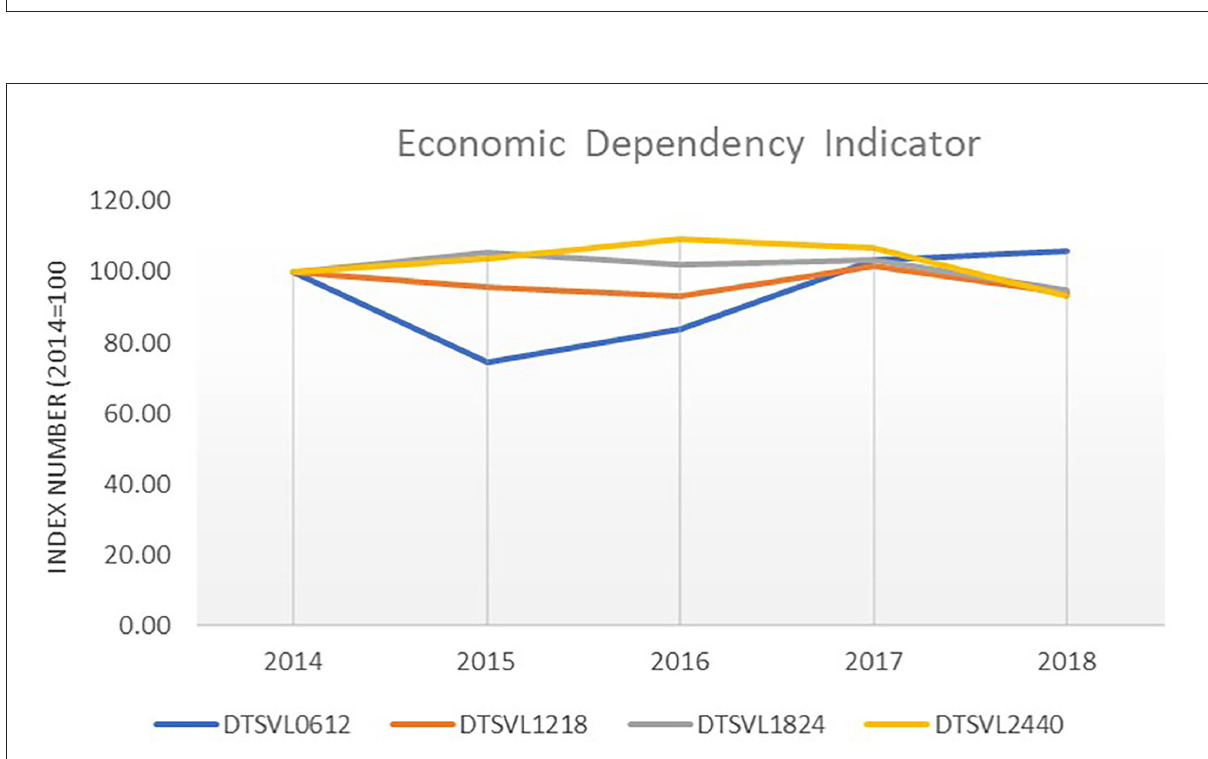
FIGURE9 EDI trend for the Italian demersal trawl fleet for the 2014–2018 period. Elaboration on data from STECF